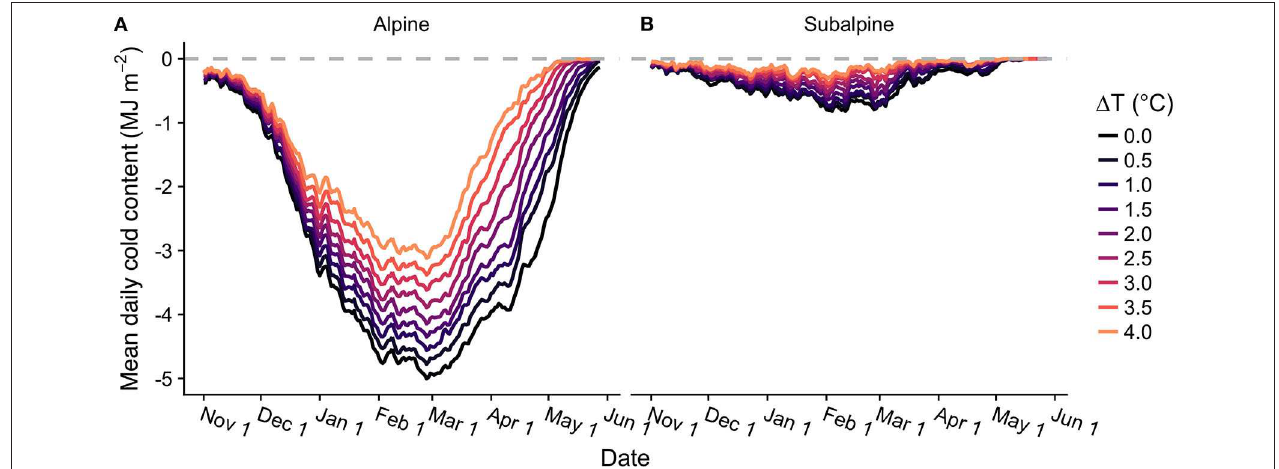
FIGURE 4 | Same as Figure 2 but for mean daily cold content.